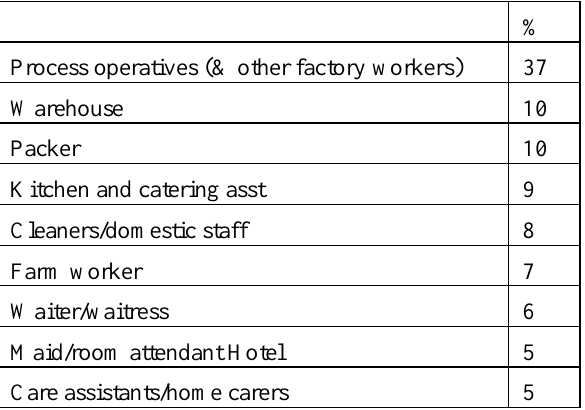
Table 4. Top Occupations of registered workers on the